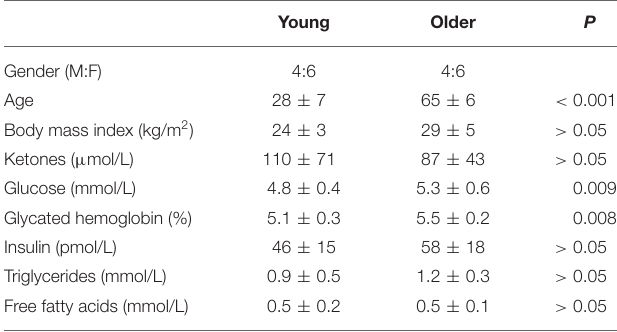
TABLE 3 | Participant characteristics.